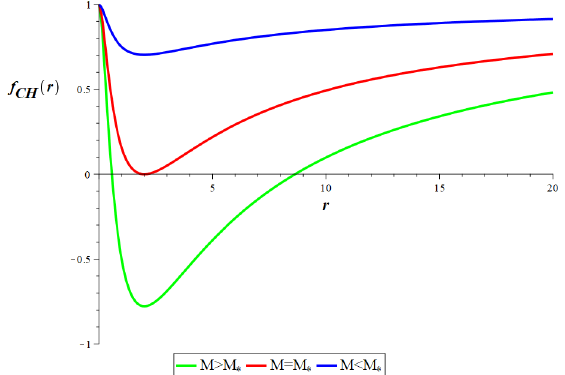
Figure 1: Plot of the Chou-Huang function f CH ( r ). Variation of the f CH ( r ) with different values of M c while maintaining h = 1, when r > 0; f CH ( r ) = 0 is the future trapping region: M > M ∗ contains two horizons, M = M ∗ contains one horizon, and M < M ∗ does not contain any